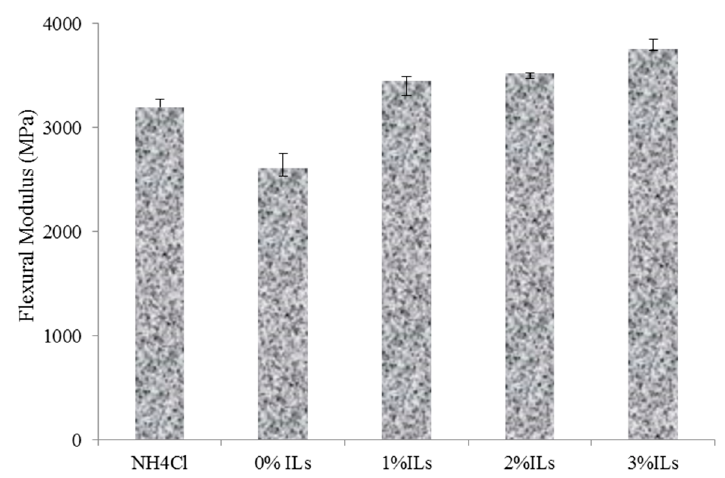
Figure 9. Flexural modulus of the manufactured panels made from synthesized resins.